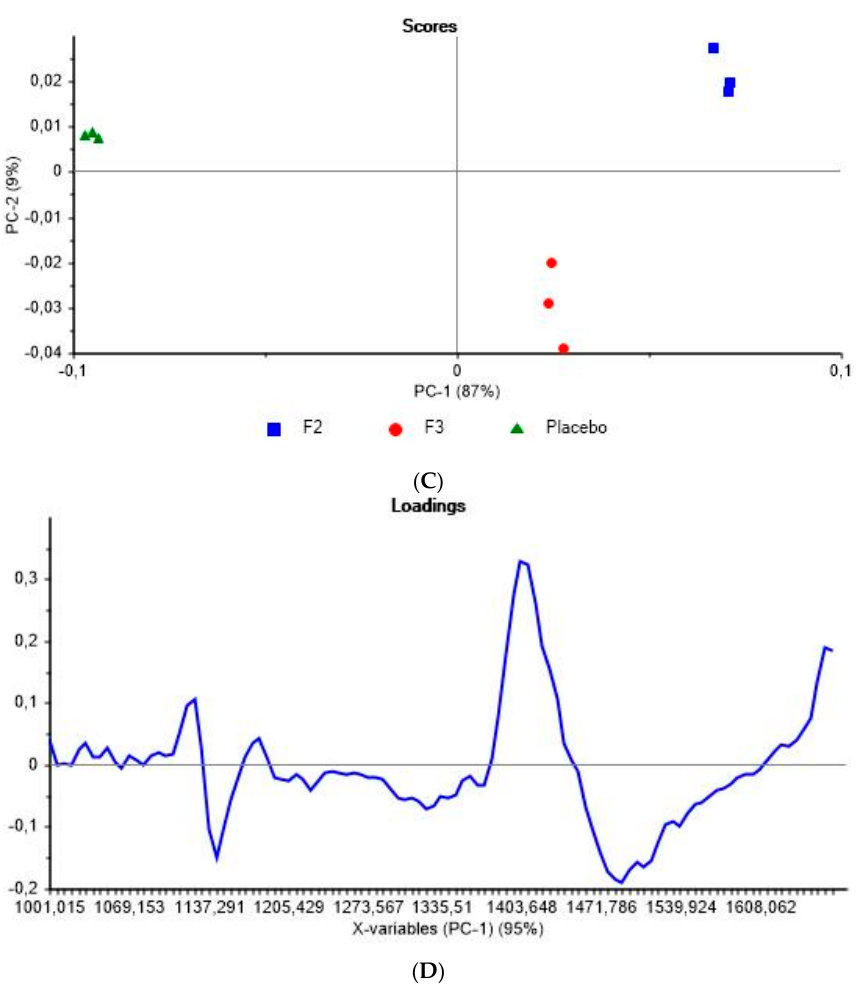
Figure 6. ( A ) Spectra of placebo sample (dark green) F3 (green) and F2 (purple line); ( B ) pretreated spectra of placebo sample (green line); F3 (red line); F2 (blue line); ( C ) Principal components analysis (PCA) plot; and ( D ) loadings plot, for placebo, F2, and F3 samples.